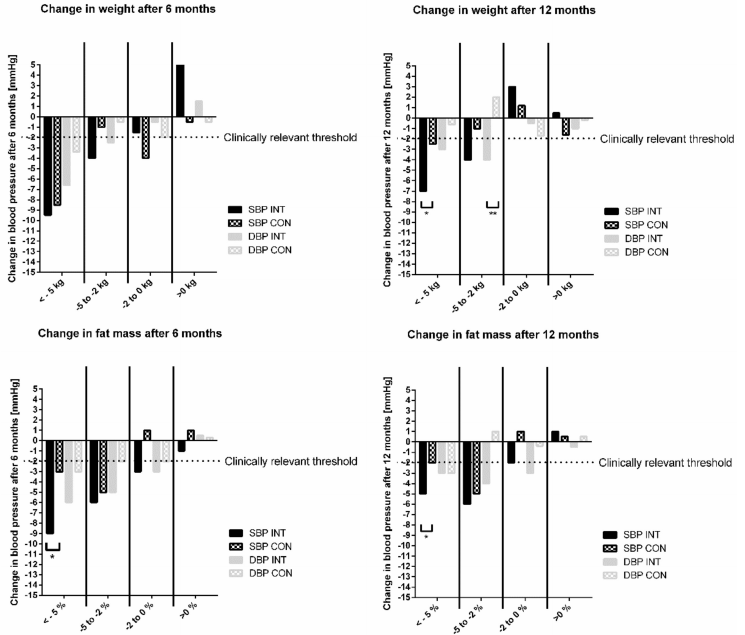
Figure 3. Clinically relevant blood pressure reduction due to weight and fat mass loss after 6 and 12 months. Data are shown as mean or percentages. ** p < 0.01; * p < 0.05. CON, control group; DBP, diastolic blood pressure; INT, intervention group; SBP, systolic blood